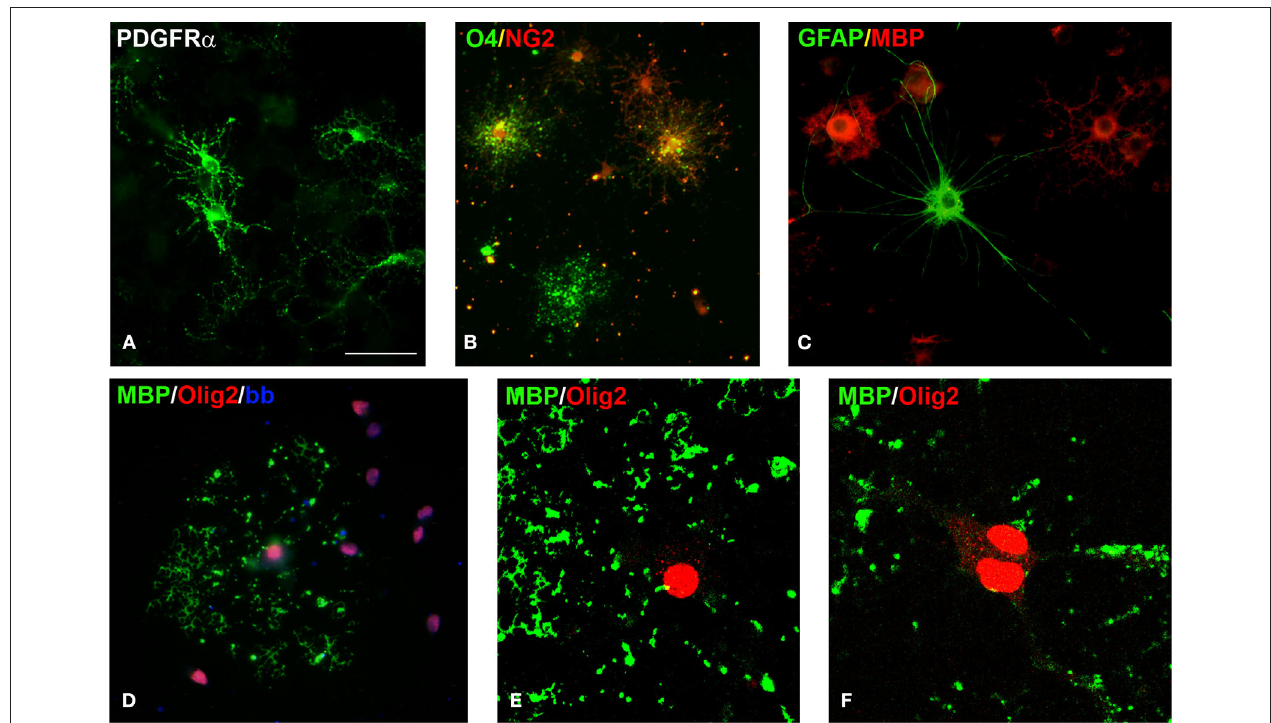
oligodendrocytes express nuclear Olig2 (red), here shown in the MBP + mature oligodendrocytes (green). (E, F) Confocal image of an oligodendrocyte with Olig2 + nucleus that produces MBP + myelin-like membrane (green). Interestingly, Olig2 expression is not localized only to the cell nucleus, but it is also seen in the cytoplasm. Scale bar: (A–D) 20 µm, (E, F) 10